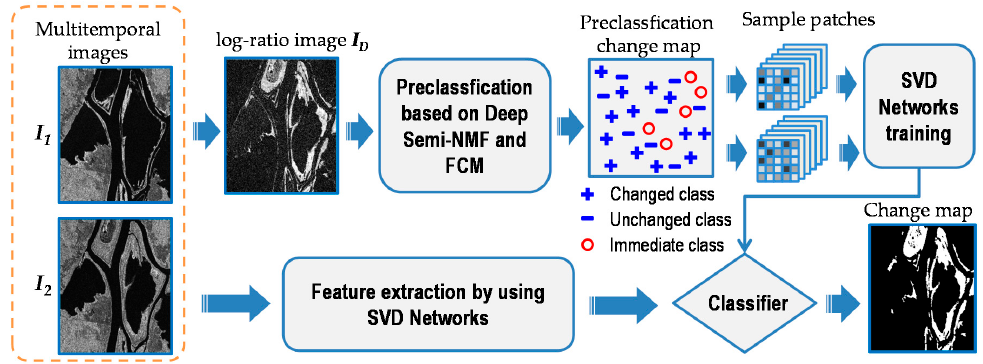
Figure 1. Flow chart of the proposed change detection method.